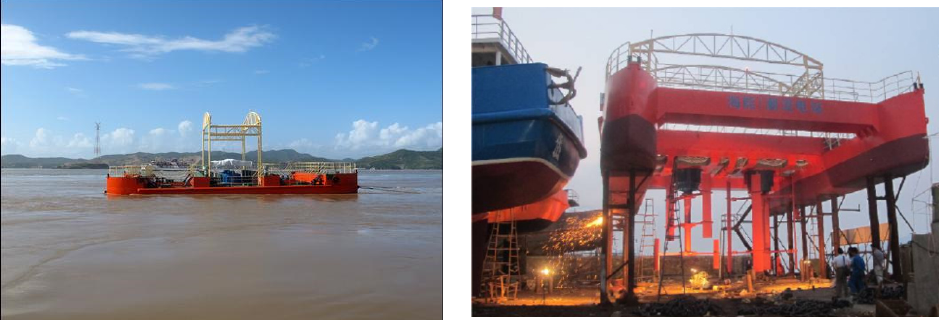
Figure 6. “Haineng I”—2 × 150 kW floating vertical-axis demonstration TCPGS. Reproduced from [22,26].